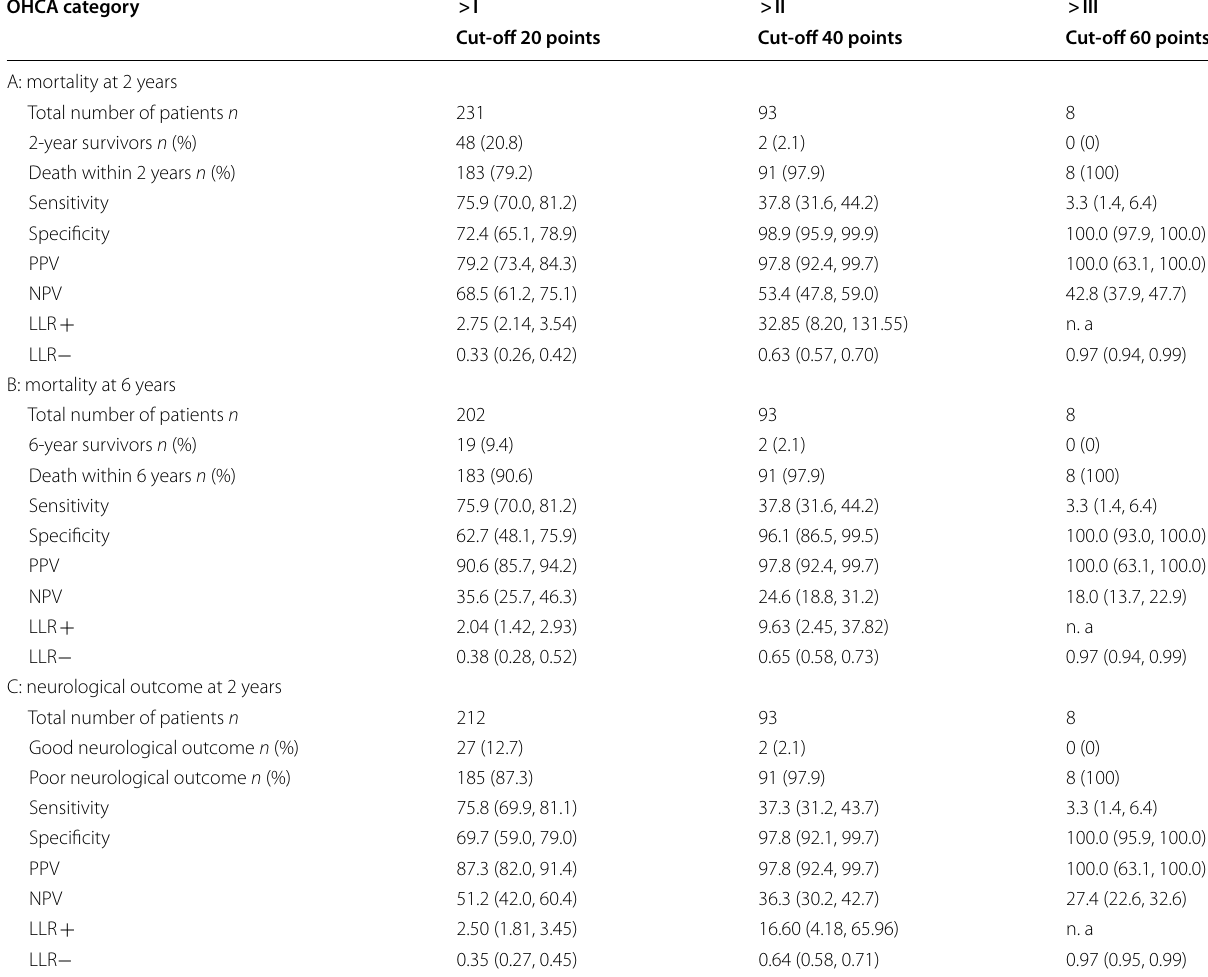
Table 3 Performance of OHCA score at different cut-off